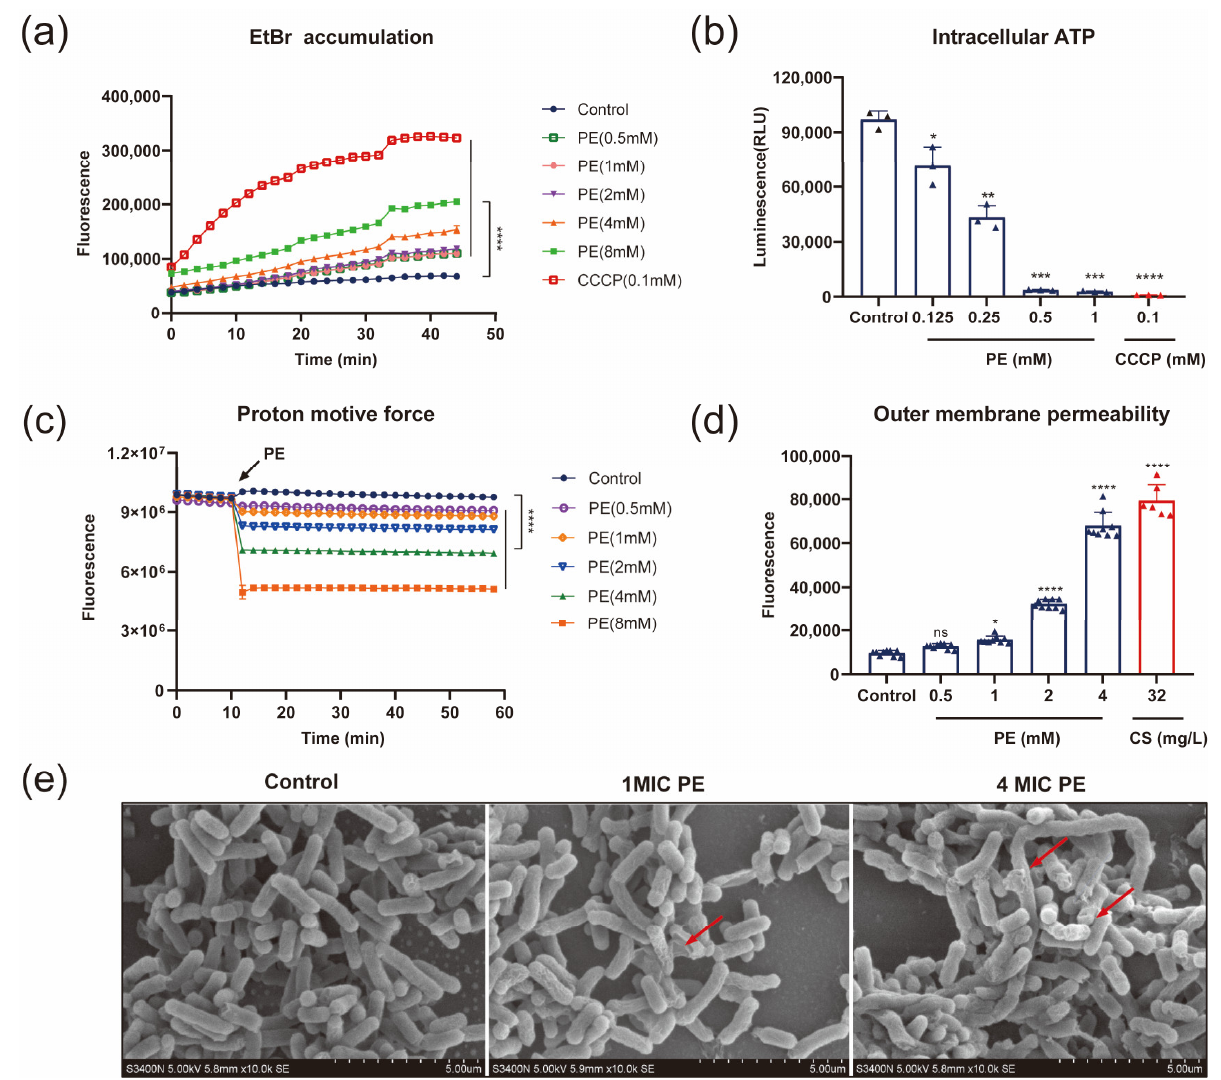
Figure 2. Phentolamine alters membrane permeability and efflux pump action. ( a ) EtBr accumulation in E. coli BW25113 treated with phentolamine. ( b ) Intracellular ATP levels of E. coli BW25113 were measured using a firefly luciferase-based ATP assay. ( c ) Measurements of ∆ pH using the fluorescent dye BCECF-AM. ( d ) Phentolamine permeabilizes the outer membrane. Permeability was evaluated by measuring the fluorescence intensity of 1-N-phenylnaphthylamine (NPN). * p < 0.05, ** p < 0.01, *** p < 0.001, **** p < 0.0001). ( e ) Scanning electron micrographs of E. coli BW25113 cells treated with phentolamine. Morphological alterations (cell fragments and wrinkled surfaces) are indicated by the arrows. Scar bar, 5 µ